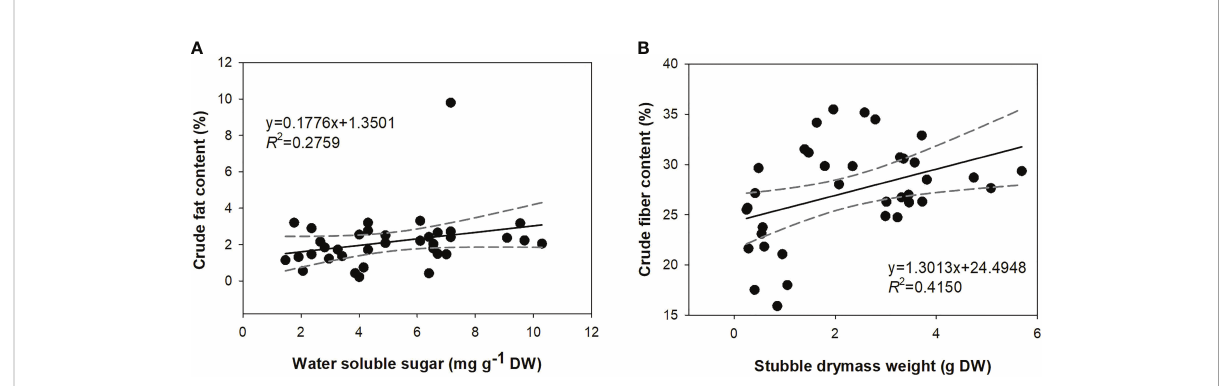
TABLE 4 Pearson analysis of the correlation between paired parameters concerning growth, DM accumulation, and physiology in alfalfa ( Medicago sativa L.) seedlings. Height DMW Sugar Starch